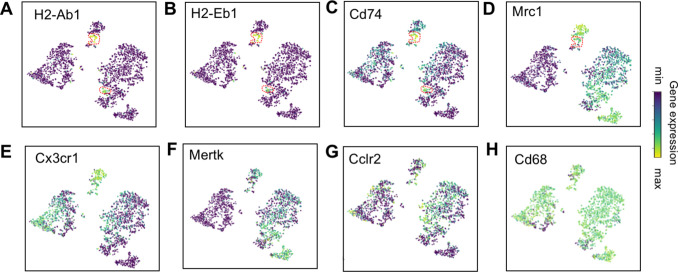
Expression of select genes in Mac IV cluster.t-SNE plots of (A) H2-Ab1, (B) H2-Eb1, (C) Cd74, and (D) Mrcl1 demonstrating differential expression in a portion of Mac IV (dotted red line). t-SNE plots of (E) Cx3cr1, (F) Mertk, (G) Cclr2, and (H) Cd68 demonstrating diffuse expression throughout Mac IV. The color scale is a logarithmic scale with a pseudocount of 0.1 counts per million, normalized to the highest expressing cell.